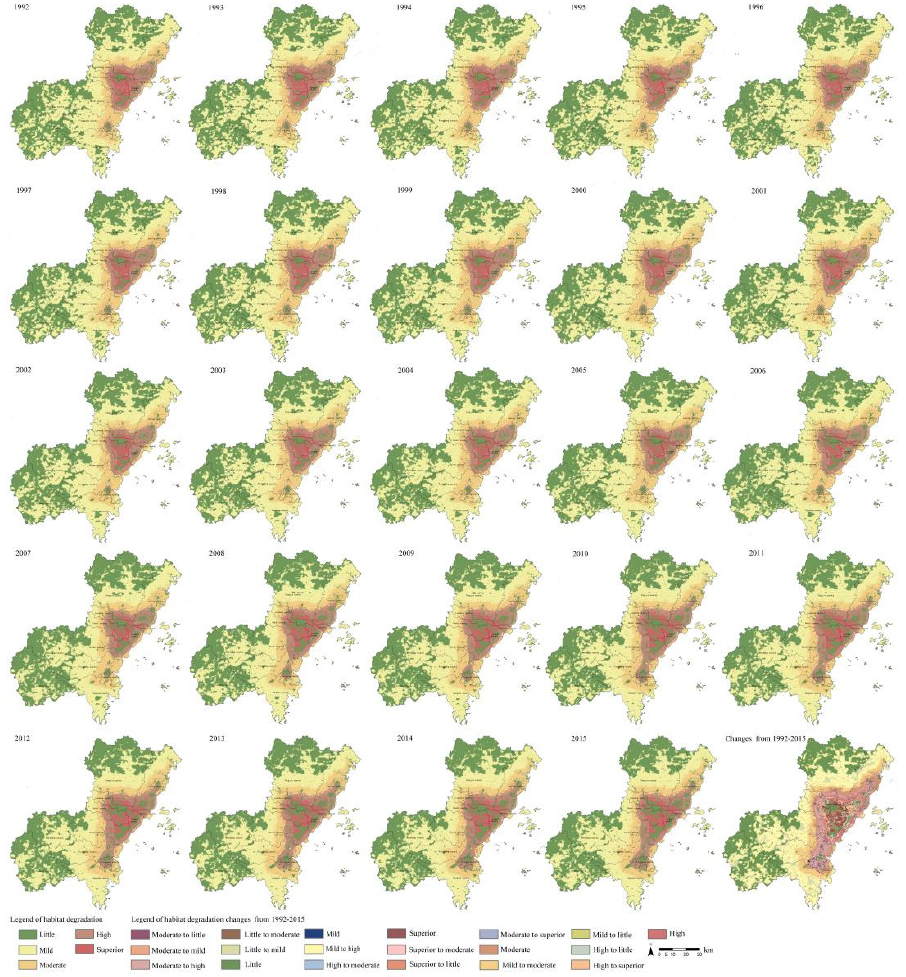
Figure 5. Changes in areas with moderate habitat degradation in each county in Wenzhou City from 1992 to 2015.